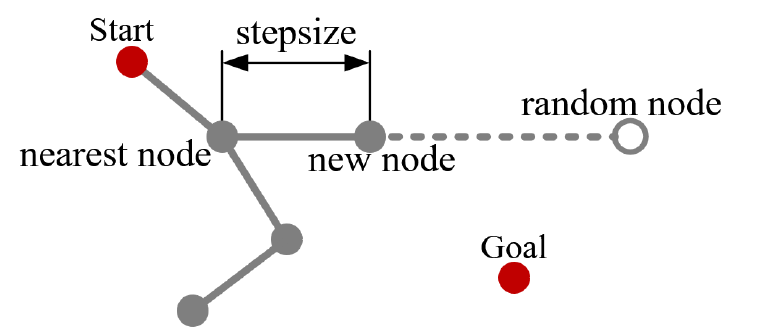
Figure 1. Principle of RRT